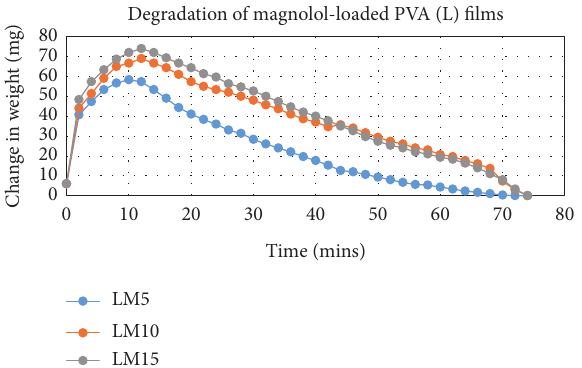
Figure 6: Degradation of magnolol-loaded PVA (L) films.